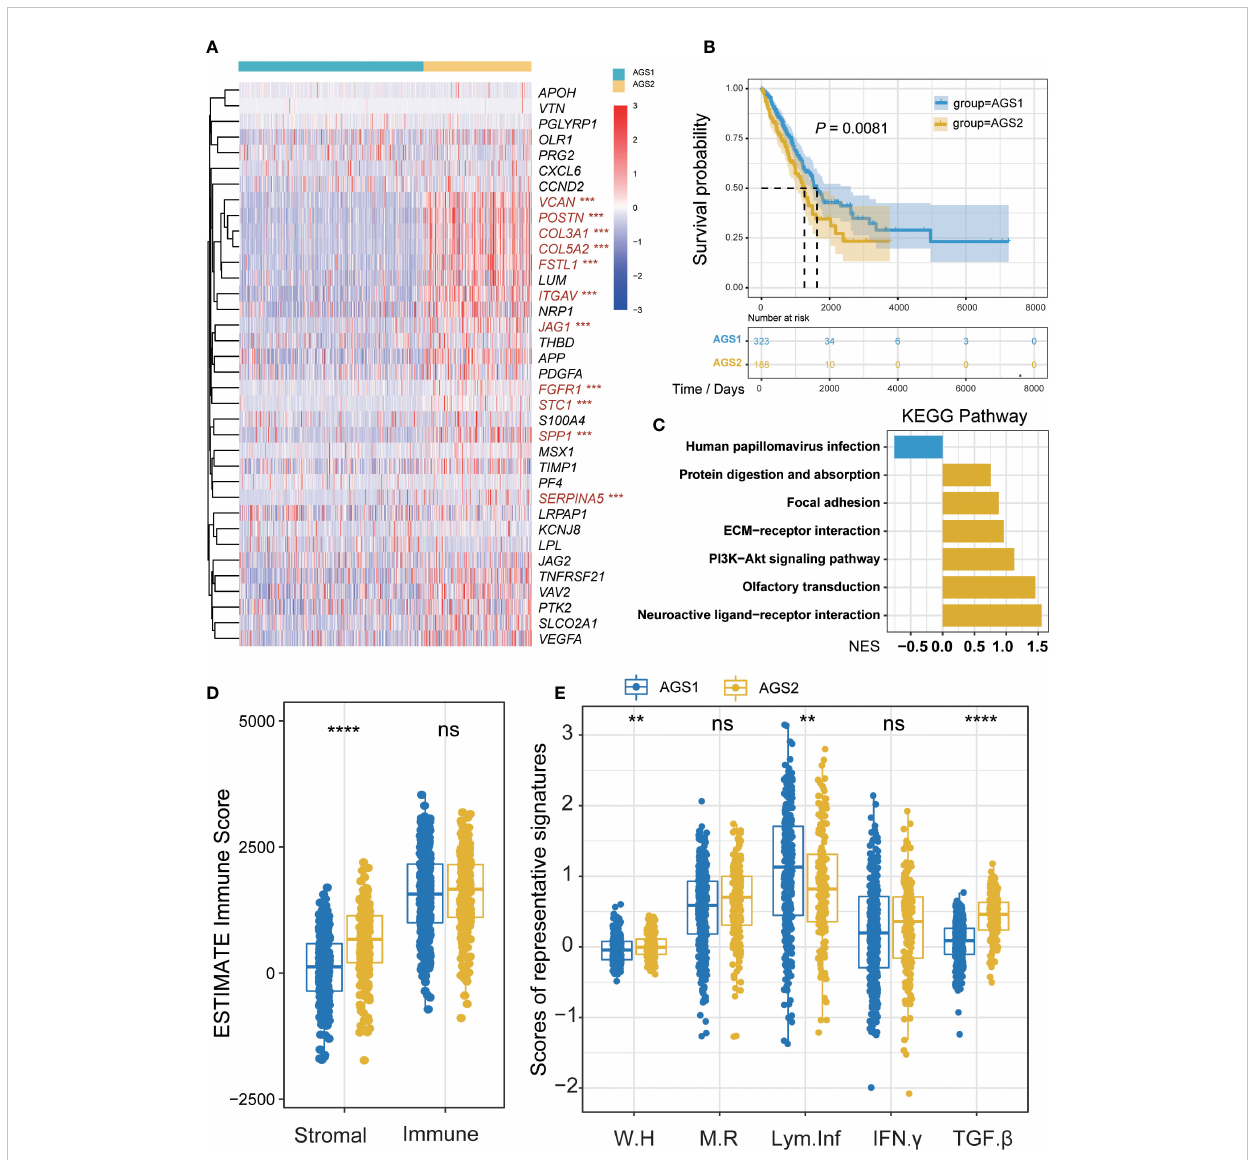
FIGURE 1 Identi fi cation of AGS clusters. (A) The heatmap of 26 AGGs expression in AGS1 and AGS2. The signi fi cantly different expressed genes were colored by red. (B) The Kaplan – Meier plot of the comparison in the overall survival between two clusters. (C) The KEGG enrichment pathway of different genes between AGS1 and AGS2. (D) The boxplot of Stromal and immune score calculated by ESTIMATE between AGS1 and AGS2. (E) The boxplot of fi ve immune expression signatures scores calculated by ssGSEA between AGS1 and AGS2. *, P < 0.05; **, P < 0.01; ***, P < 0.001; ****, P < 0.0001. ns represents p value is not signi fi